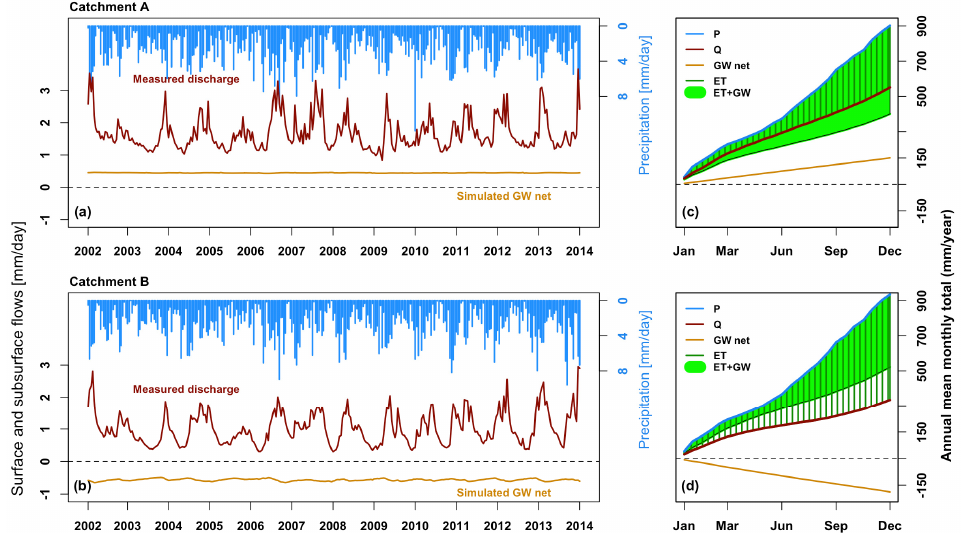
Figure 5. ( a ) Two-week-interval timeseries of the measured discharge (Q) and simulated groundwater net (GW-net), and ( c ) annual mean monthly totals of precipitation (P), Q, GW-net, surface water balance evapotranspiration (WB ET), and surface WB ET plus GW-net (ET + GW) for catchment A . ( b , d ) the same as in ( a , c ), but for catchment B . In the graph, positive (negative) values of GW-net indicate inflow (outflow). The units for a/b and c/d are mm/day and mm/year, respectively. To see the locations of catchments A and B , it is referred to Figure 1b.